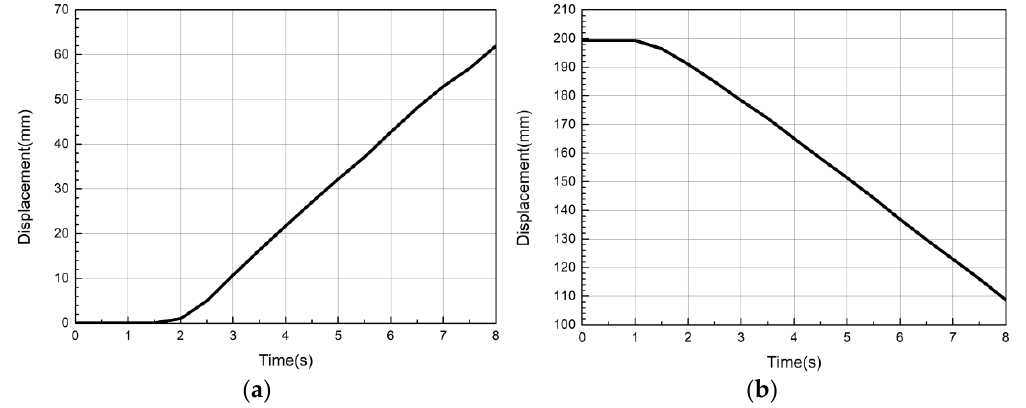
Figure 13. Displacement graph: ( a ) forward motion; ( b ) reverse motion.